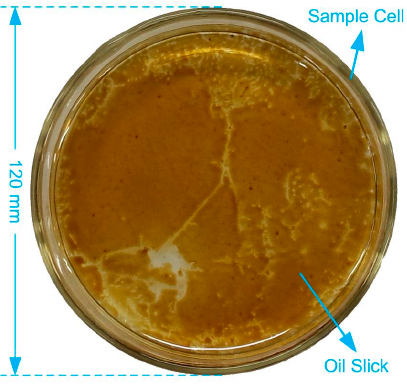
Figure 2. The picture of the prepared crude oil sample floating on the surface of sea water.